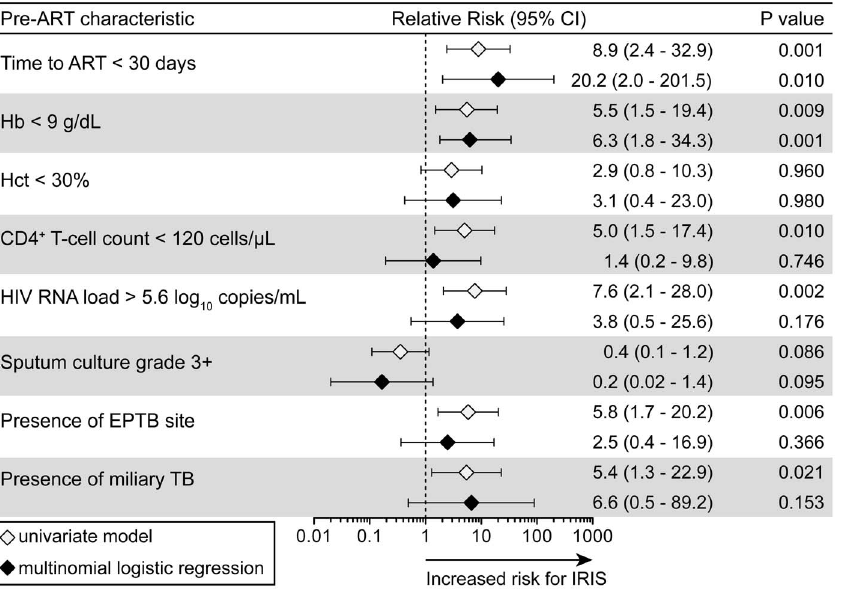
Figure 1. Associations between pre-ART clinical and laboratory characteristics with subsequent TB-IRIS events. Baseline (pre-ART) characteristics significantly different between patients that developed TB-IRIS events in the follow up and those who did not were assessed to test associations with risk for IRIS in univariate and multinomial logistic models. Relative risks (RR) are for values below or above the threshold levels displayed, which were estimated close to median values for the overall study population. Adjustment was performed for all variables presented and also included age and gender. 95% CI, 95% confidence interval.